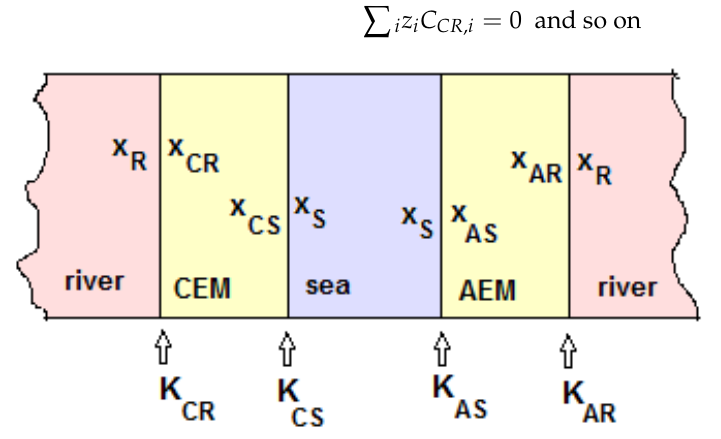
Figure 7. Mole fractions at the four interfaces. Instead of molarity (molar concentration) C (in mol/L) of a specific ion, I prefer using normality N (in Eq/L). For monovalent ions, C and N have the same value. In the case of a divalent ion, the relationship is given by N = 2 C . In the following, mainly solutions of NaCl with variable MgSO 4 concentrations are considered. I apply the Donnan and electroneutrality equations to the membrane interfaces of CEMs with different charge densities and calculate the membrane concentrations of the four ions . Figure 8 shows the equivalent percentage of magnesium (Mg%) in the gel phase of three membranes (with charge densities of 1, 3, and 9 Eq/L) as function of the bulk Mg%. In Table 3, some data are presented from the ionic concentrations as found in sea and Lake IJssel feed water with total salt concentrations 0.006 Eq/L and 0.6 Eq/L. Magnesium and calcium ions are between Mg 2+ and Ca 2+ . The same method is used for the prediction of the amount of sulfate in the outer sides of an